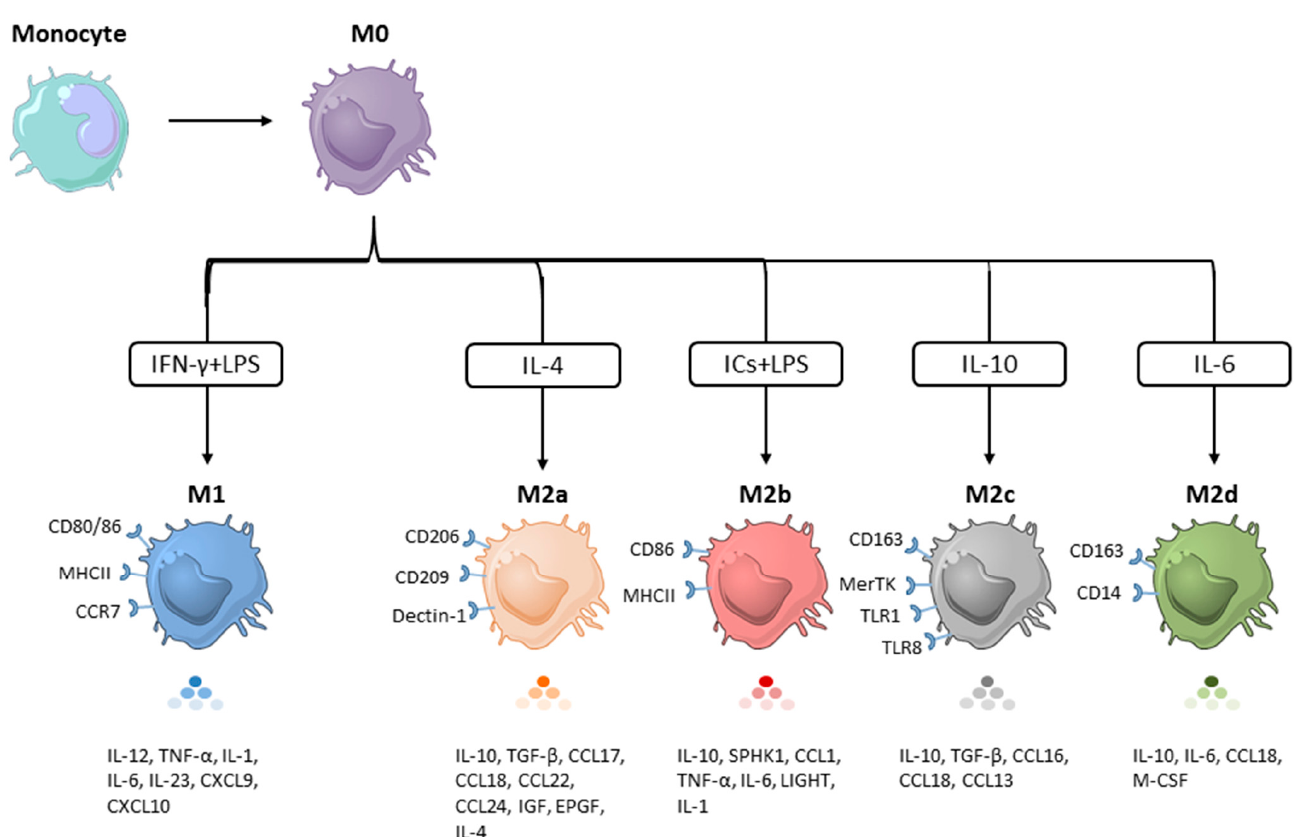
Figure 5. A graphic overview of macrophage polarization and their characteristics. Macrophages are first differentiated from their precursor monocytes to uncommitted M0 macrophages. In response to different stimuli, M0 macrophages can further polarize into distinct subsets with characteristic phenotypic markers and cytokine production profiles.